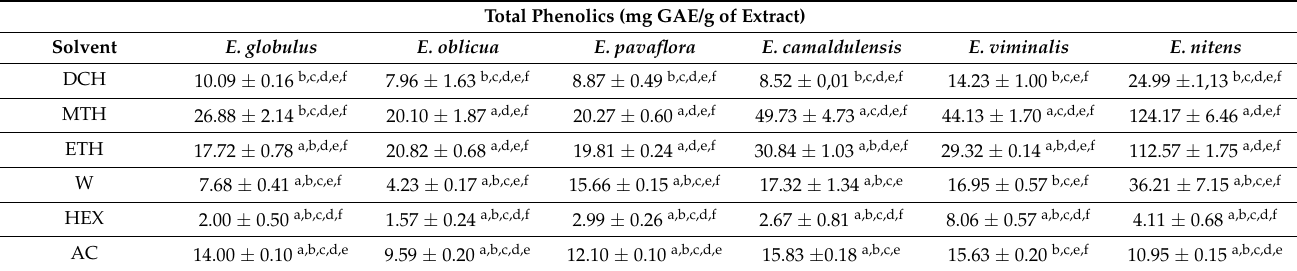
Table 4. Total phenolics obtained, expressed as mg gallic acid/g extract.